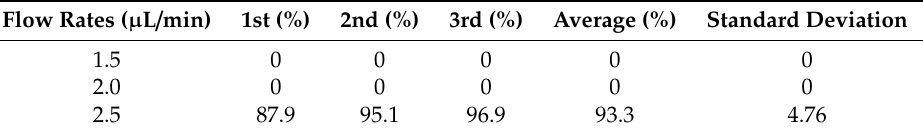
Table 3. The trapping e ffi ciencies in the DEP